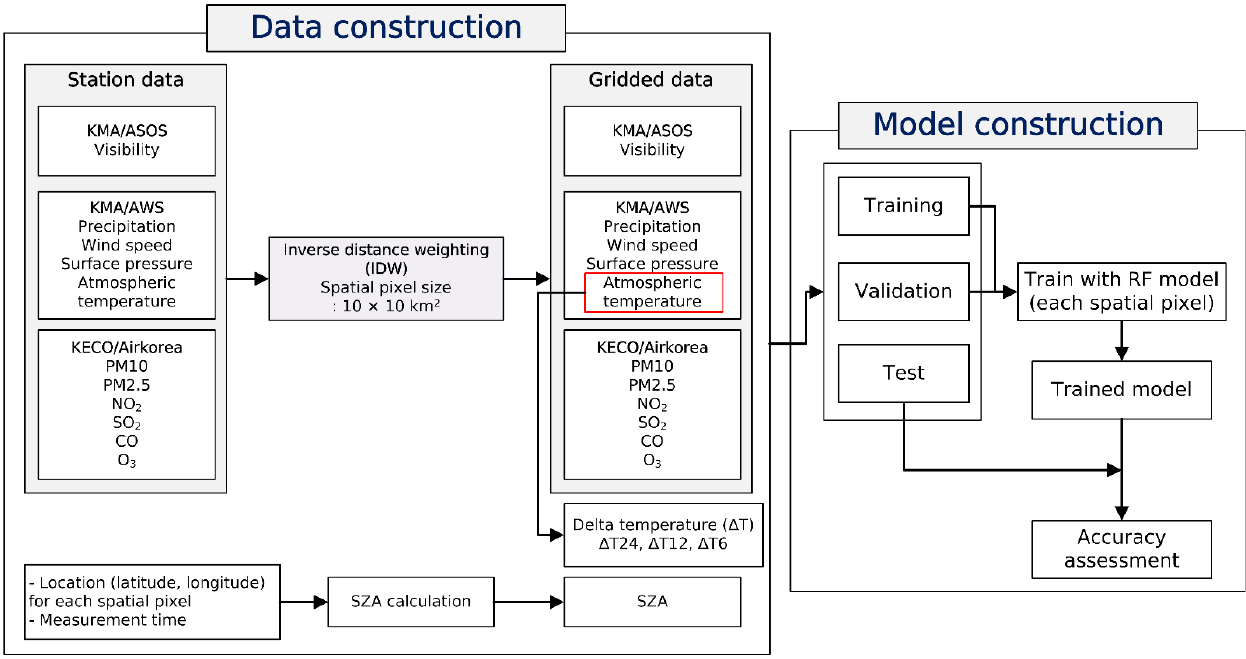
Figure 1. Flowchart of development of visibility estimation model.